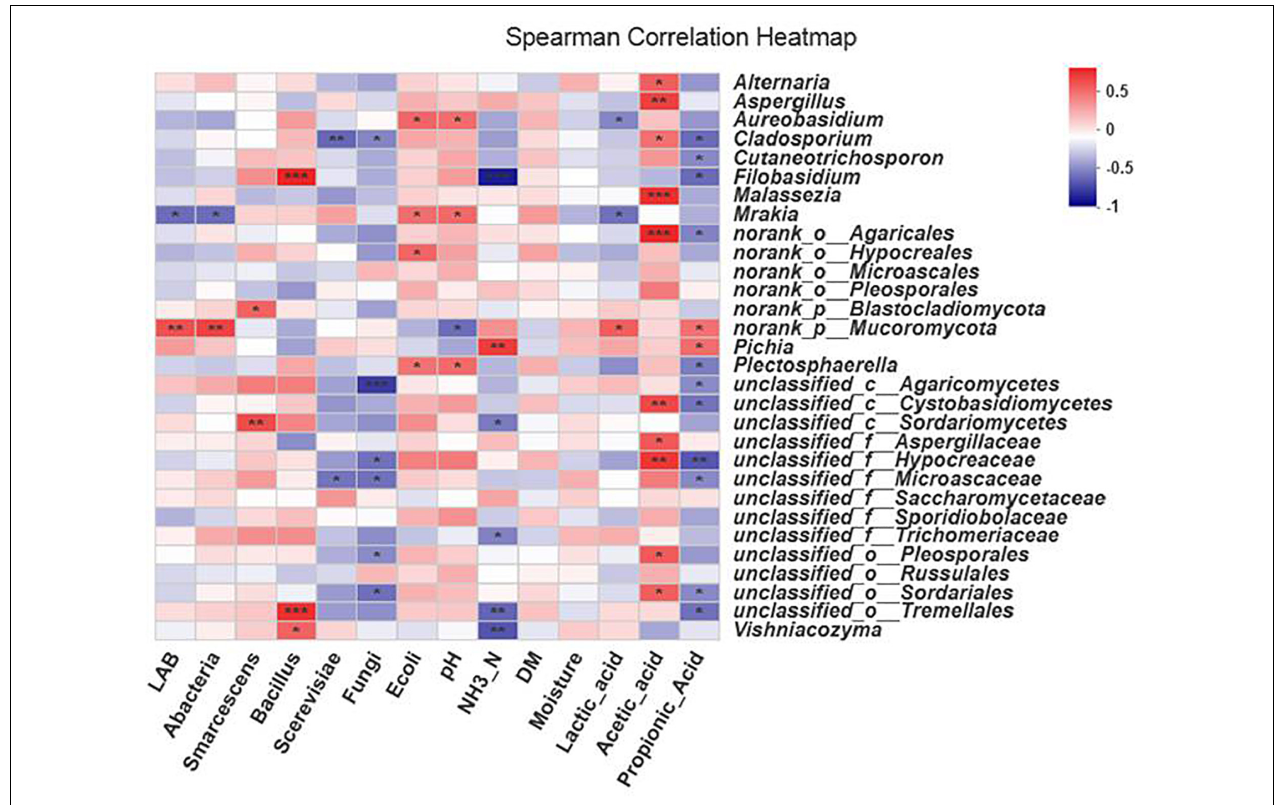
FIGURE 8 | Spearman’s correlation heat map for fungi at the genus level. ∗ 0.01 < P ≤ 0.05, ∗∗ 0.001 < P ≤ 0.01, ∗∗∗ P ≤ 0.001. The x -axis and y -axis are environmental factors and species, respectively. Different R values are shown in different colors.